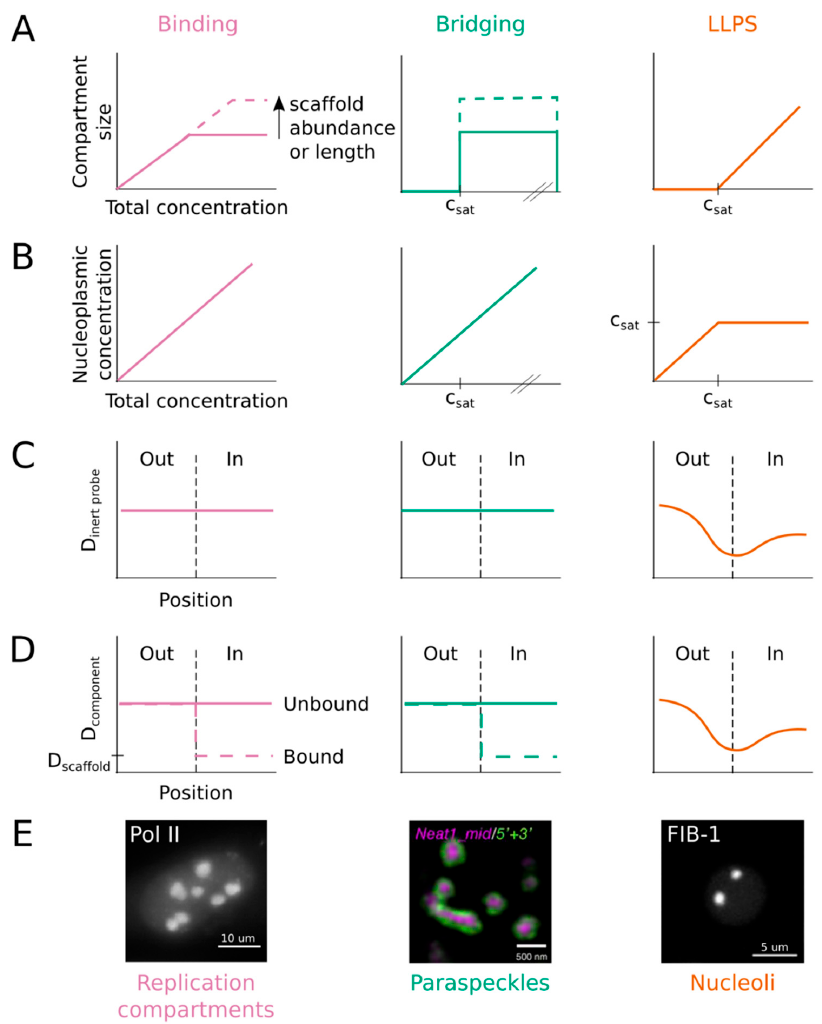
Figure 3. Concentration dependence and diffusion across boundary represent useful criteria for distinguishing among various mechanisms for nuclear compartmentalization. ( A ) Each model predicts a distinct relationship between compartment size and component concentration. ( B ) LLPS can buffer the nucleoplasmic concentration, while binding and bridging mechanisms cannot. ( C ) Inert probes freely diffuse through compartments formed by binding or bridging, but their mobility is hindered by the phase boundary. ( D ) Component molecules move similarly to inert probes except when bound to the polymer scaffold. ( E ) Despite their spherical shape and molecular dynamics, replication compartments and paraspeckles are not consistent with LLPS. Images are reprinted from refs. [33,40,61] under the Creative Commons license: http: // creativecommons.org / licenses / by / 4.0 /